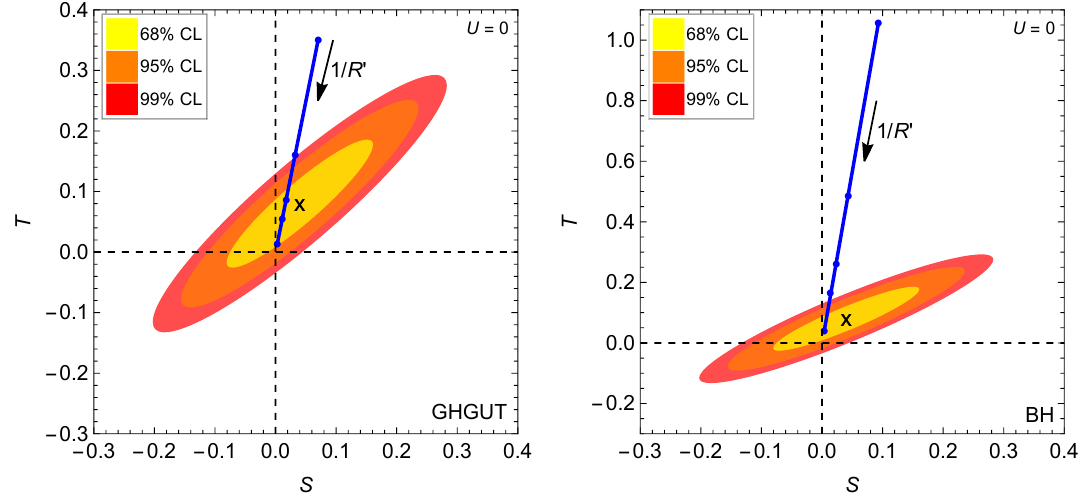
Figure 5 . Regions allowed at 68% , 95% , and 99% CL in the S − T plane with U = 0 ( m t, ref . = 172 . 5 GeV, m H, ref . = 125 GeV) [144]. The blue line represents the contributions in our GHGUT (left) and in a Brane-Higgs (BH) scenario [54] (right) for 1 /R 0 ∈ [2 , 10] TeV and 1 /R = 10 18 GeV. Note that both models are without custodial protection. 1 /R 0 increases in the direction of the arrow and the blue dots represent the values 1 /R 0 = 2 , 3 , 4 , 5 , 10 TeV. See text for